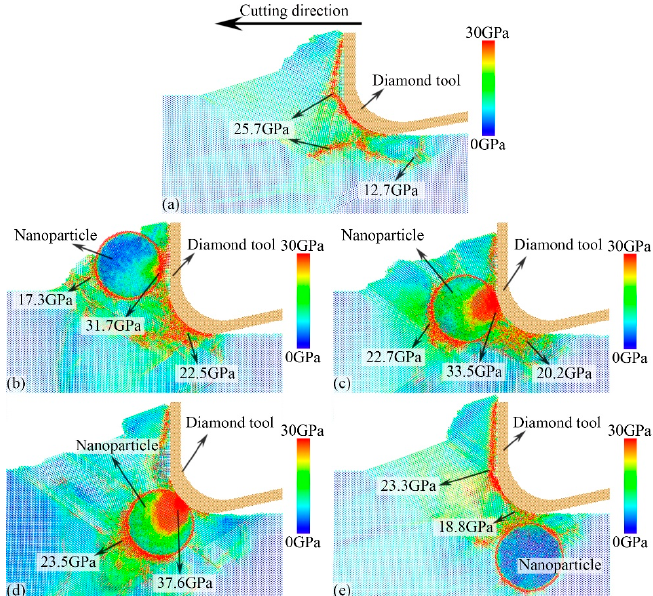
Figure 4. Snapshots of the von Mises stress distribution in the subsurface of the workpiece with no NPs ( a ), with NP for ∆ D = 4 nm ( b ), 2 nm ( c ), 0 nm ( d ), and − 5 nm ( e ) at cutting distance of 15 nm.